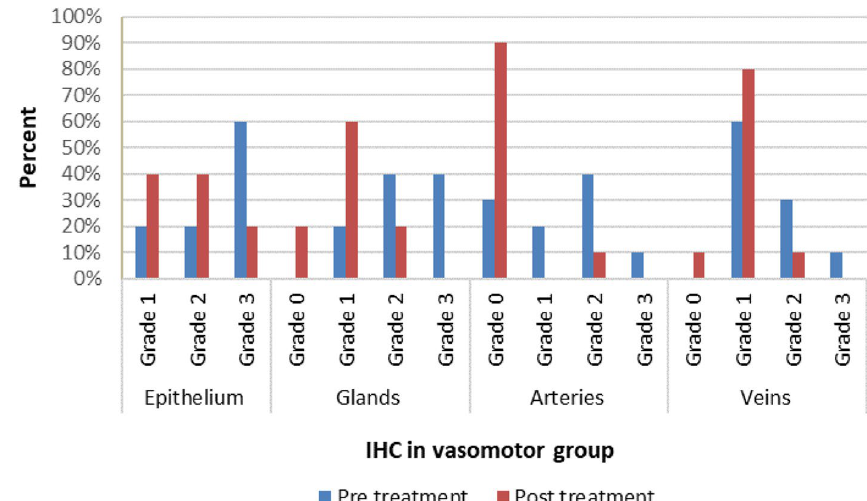
Fig. 1 Comparison between the pre- and post-IHC data among vasomotor cases study groups